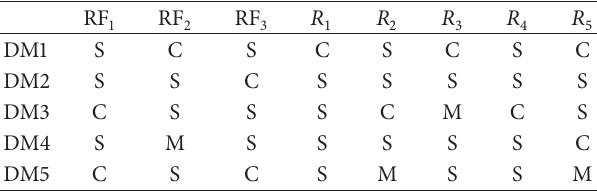
Table 4: Impact of risk (I) for risk factors and